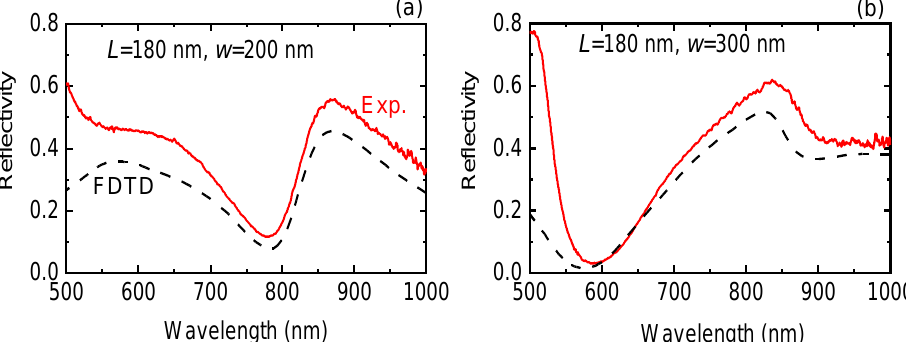
Figure 6. Experimental (Exp; red) and calculated (FDTD; dashed) reflectivity spectra of Au nanoprisms with L = 180 nm side length. The thicknesses of the SiO 2 spacer were ( a ) w = 200 nm and ( b ) 300